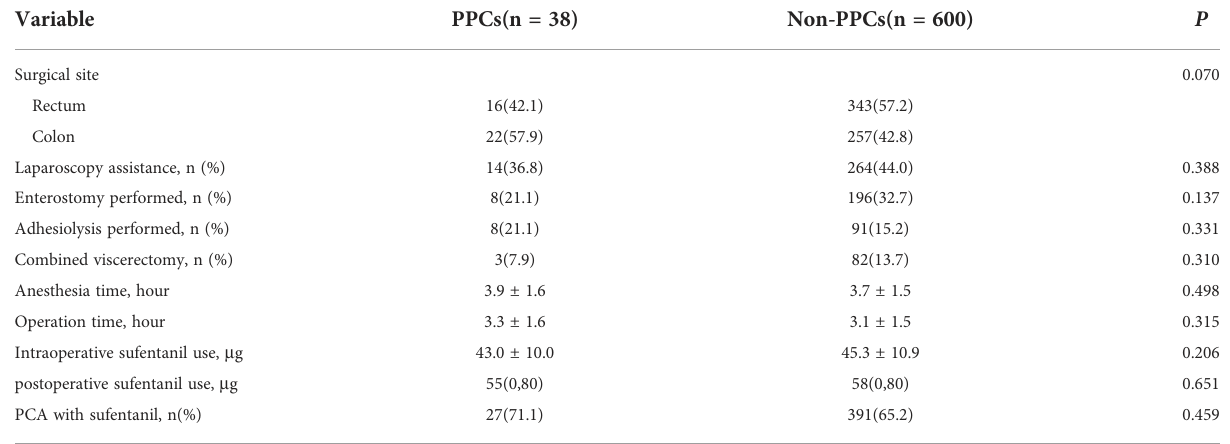
TABLE 2 Surgical and anesthesia characteristics of patients.